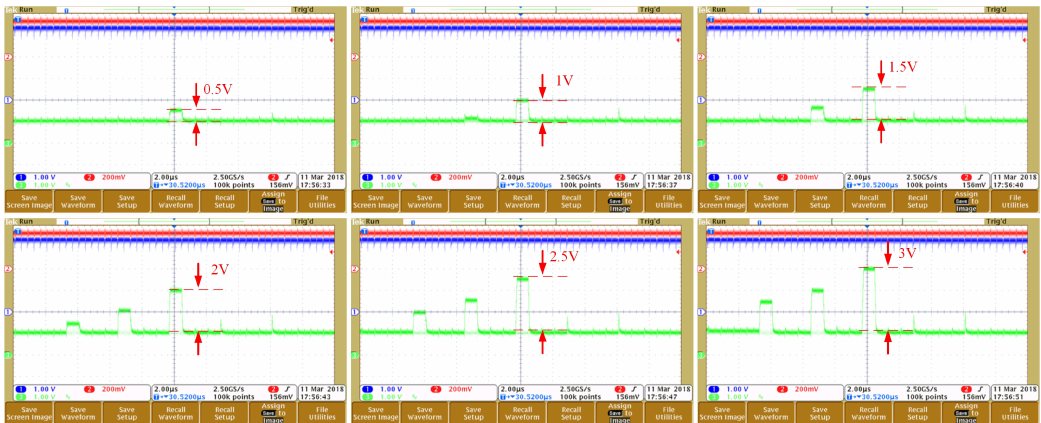
Figure 9. ROIC output voltage with increased temperature.